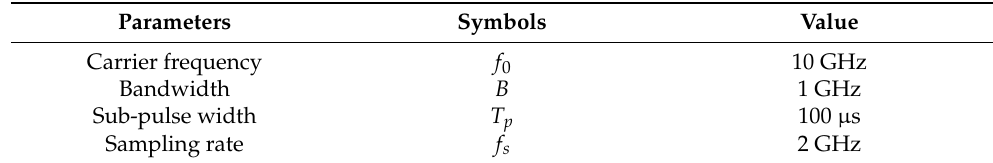
Table 2. The simulation parameters of LFM.